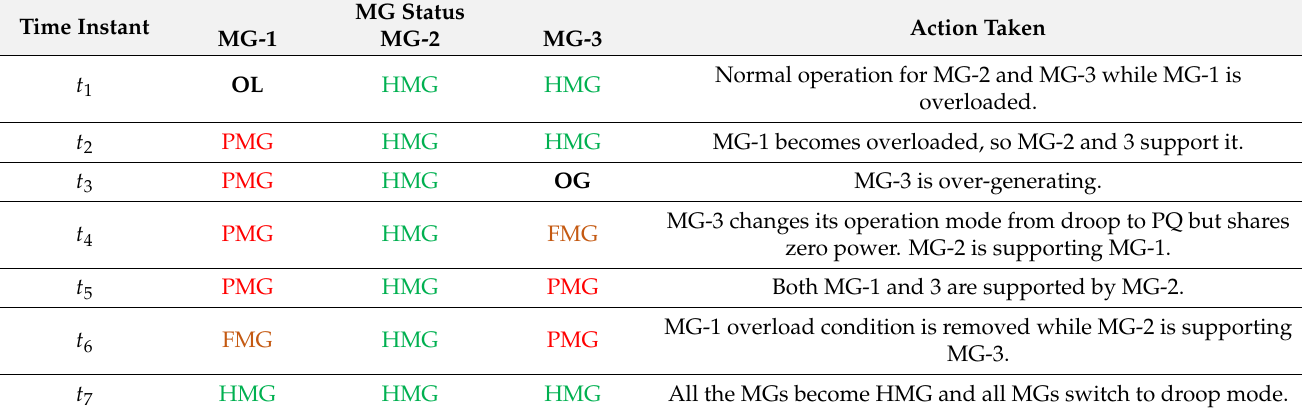
Table 2. Overloading and over-generating events applied to MGs in case study 2 at different